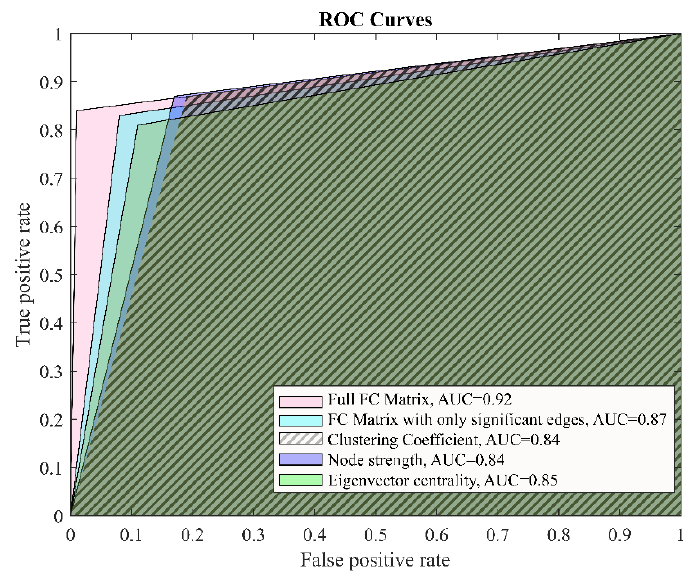
Figure 4. Receiver operating characteristic for the LDA classifiers for different feature vectors, AUC = area under curve.